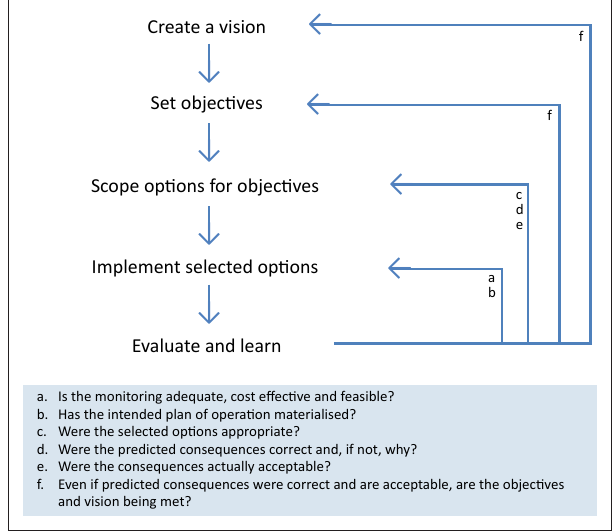
FIGURE 3: The adaptive management process with feedback loops for ongoing reflective learning at multiple points during the